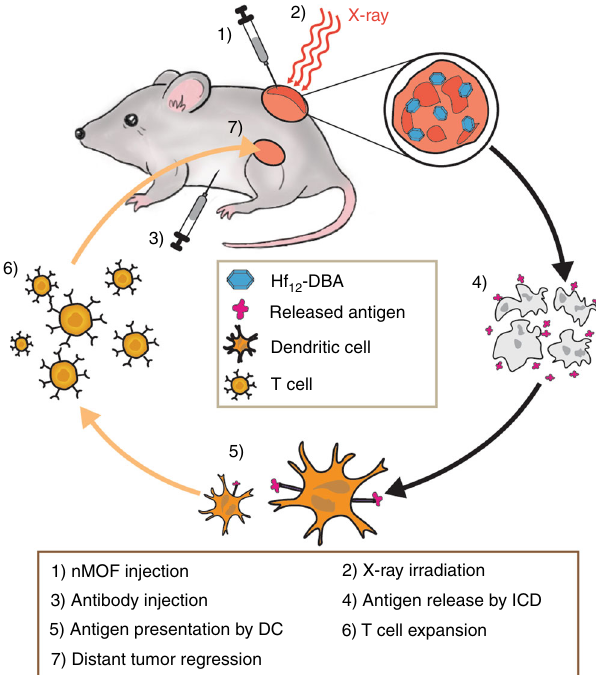
Fig. 7 Abscopal effect of nMOF-mediated RT and immune checkpoint blockade using fractionated X-rays. nMOF was intratumorally injected into the primary tumors of mice bearing bilateral subcutaneous tumors. nMOF- mediated RT destroyed the irradiated tumors, caused immunogenic cell death, and released tumor antigen. Injected anti-PD-L1 antibody overcame the suppressive tumor microenvironment by targeting PD-1/PD-L1 axis. The combination of nMOF-mediated RT and anti-PD-L1 checkpoint blockade led to the effective T cell expansion and tumor in fi ltration, which effectively suppressed/eradicated the distant